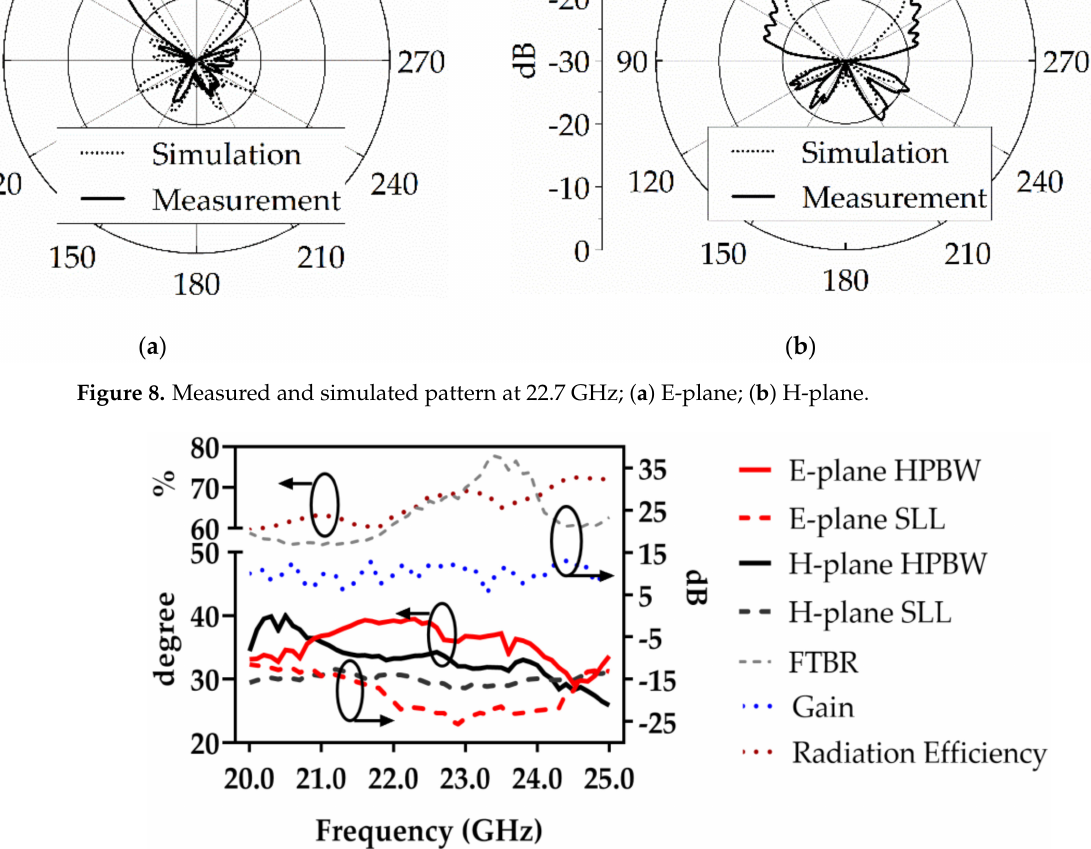
Figure 9. The measured radiation characteristics from 20 to 25